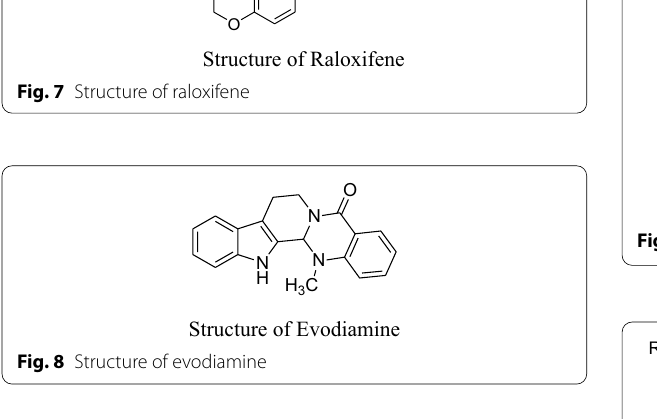
Fig. 7 Structure of raloxifene